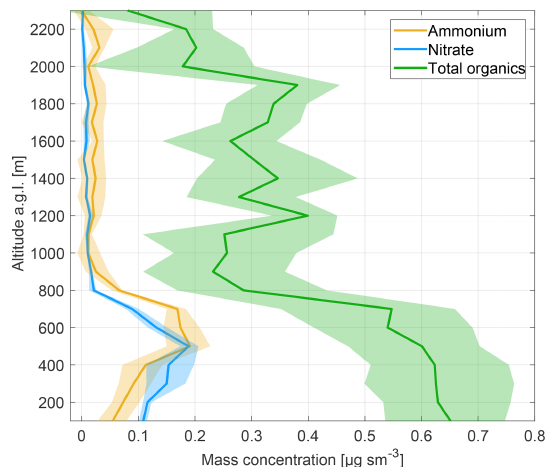
Figure 5. Vertical profiles (in 100m bins, shading indicates lower and upper quartiles) of ammonium, nitrate and total organics as ob- served during a missed approach at Meadows Field Airport, which is located approximately 5km NW of downtown Bakersfield, Cali- fornia. The data were taken in the period between 10:48 and 10:55 local time, 17:48 and 17:55